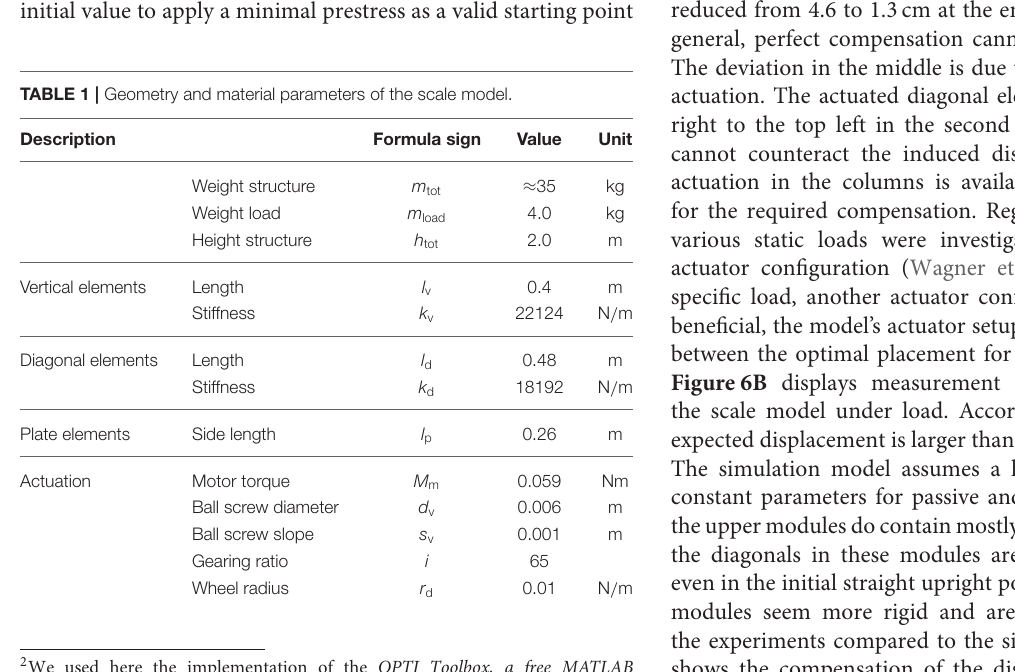
Frontiers in Built Environment |